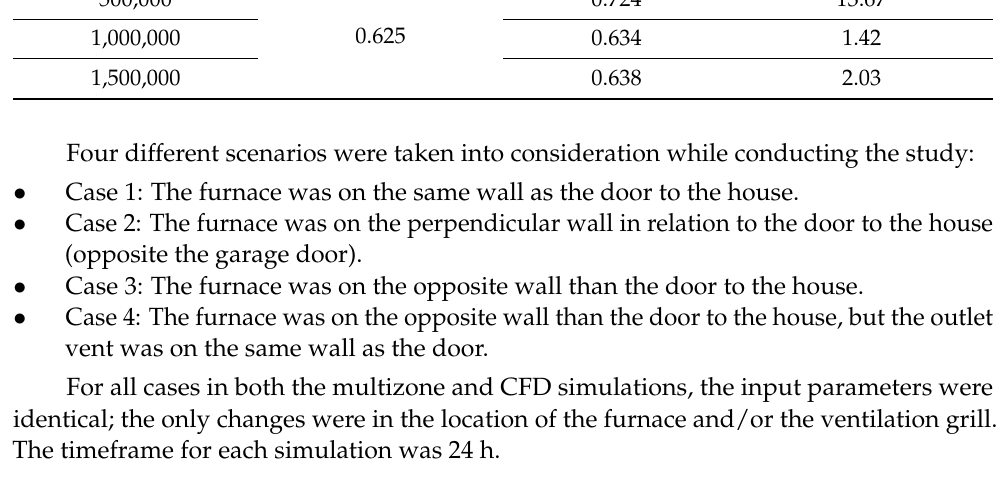
Table 3. Grid independence